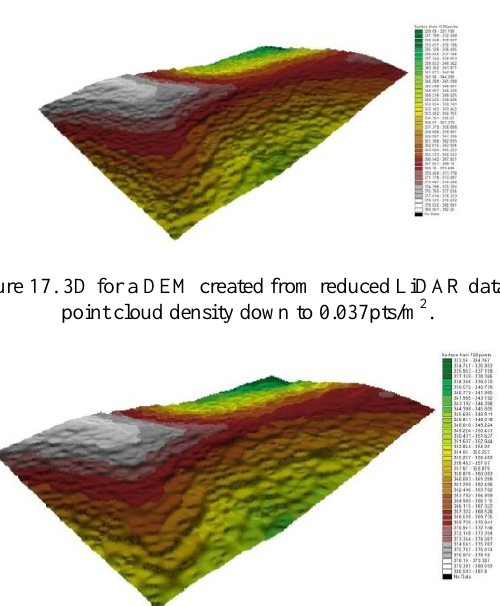
Figure 19. The effects of reductions in LiDAR data on the ranges of the DEM elevations.